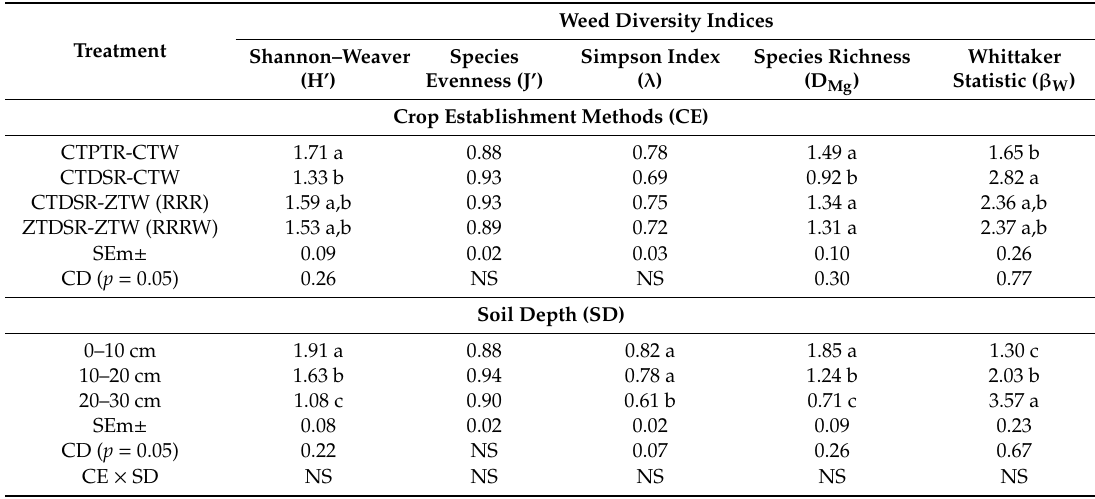
Table 7. E ff ects of crop establishment methods and soil depth on weed diversity indices.